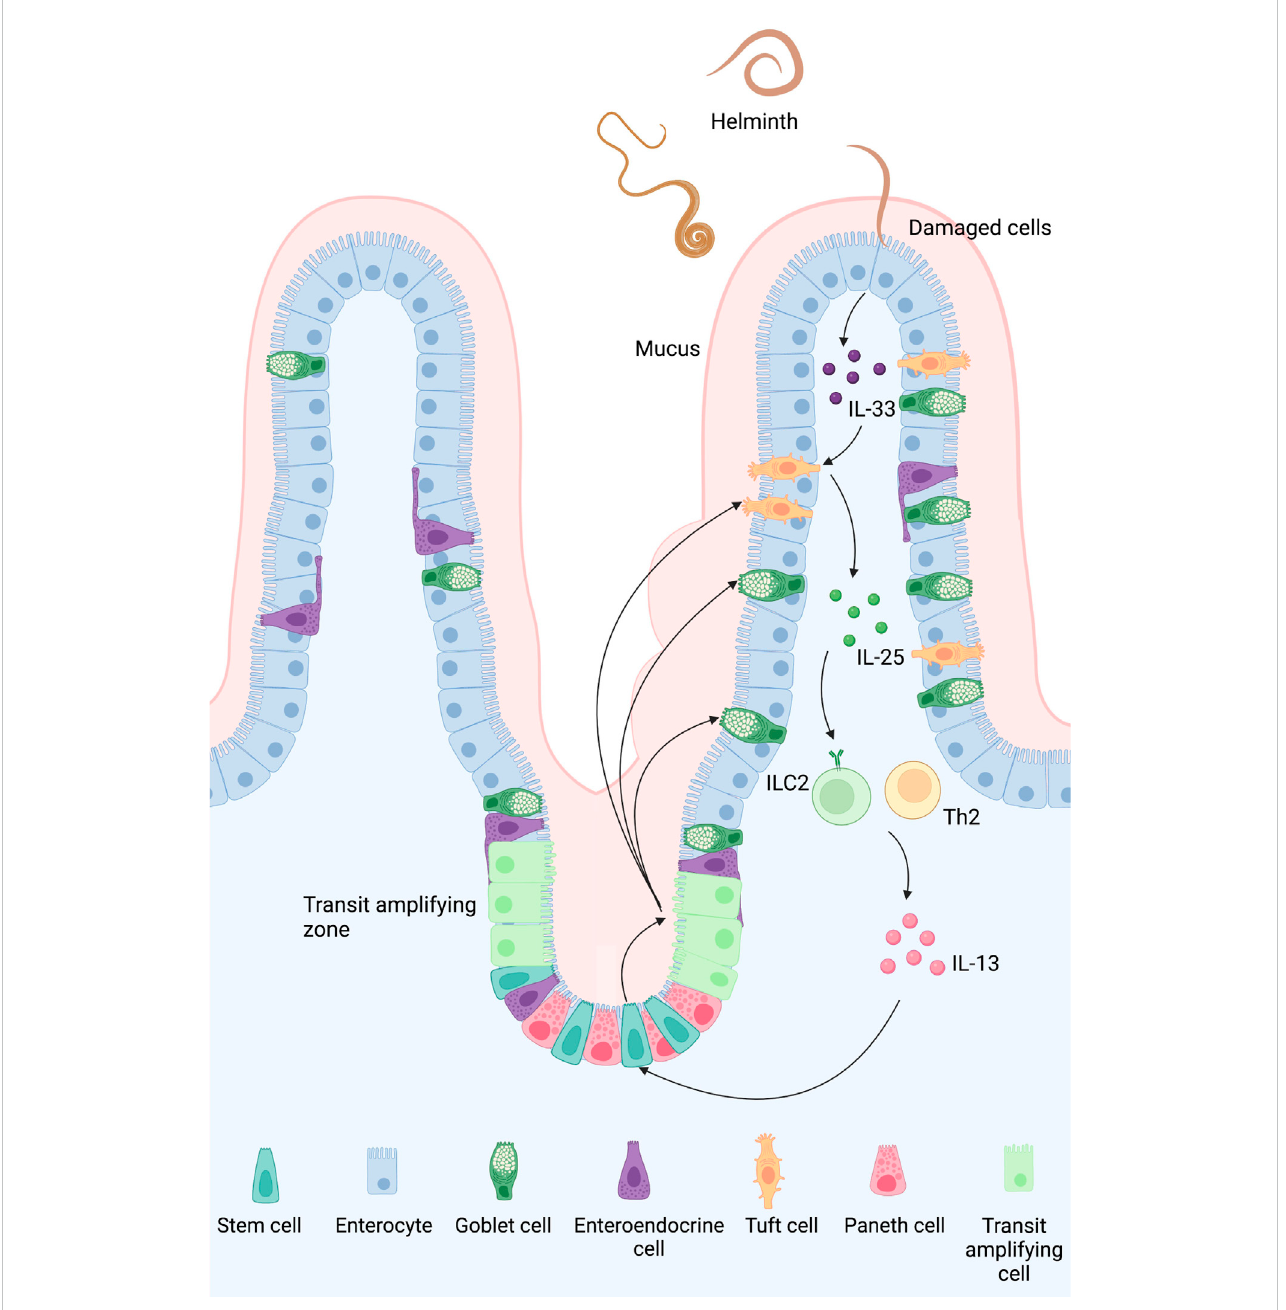
FIGURE 3 Type 2 immune response orchestrated by TCs in the small intestine: A feed-forward loop of the tuft 2-ILC2 axis can be observed in the early stage of intestinal helminth infection. Once the epithelial cells are damaged by a helminth, they release IL-33 and trigger TCs to secrete IL-25. Activated by these cytokines,ILC2thenproducesIL-4andIL-13,whichpromotesgobletandtufthyperplasiaandsmoothmusclecontraction.Althoughtheexactmechanismof how TCs sense an infection in the fi rst place is still unclear, TCs might sense succinate secreted by helminth and bacteria via protein-coupled succinate receptor SUCNR1. An intracellular Ca 2+ fl ux follows the signal and opens the cation channel TRPM5, causing a Na + in fl ux which depolarizes